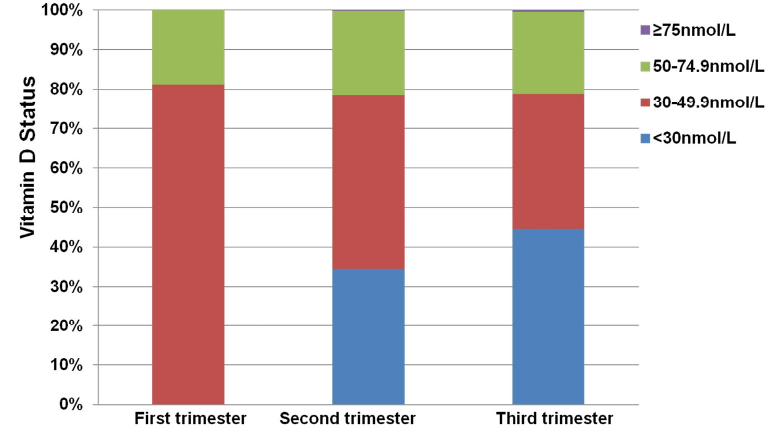
Figure 1. Vitamin D status among pregnant women in the first, the second and the third trimester.